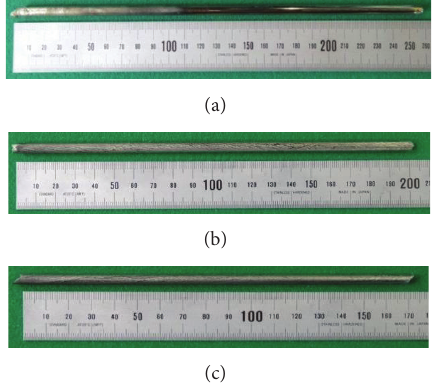
Figure 4: Photographs of U–10Zr–5Mn slugs prepared in (a) test 𝑒 , (b) test 𝑓 , and (c) test 𝑔 .